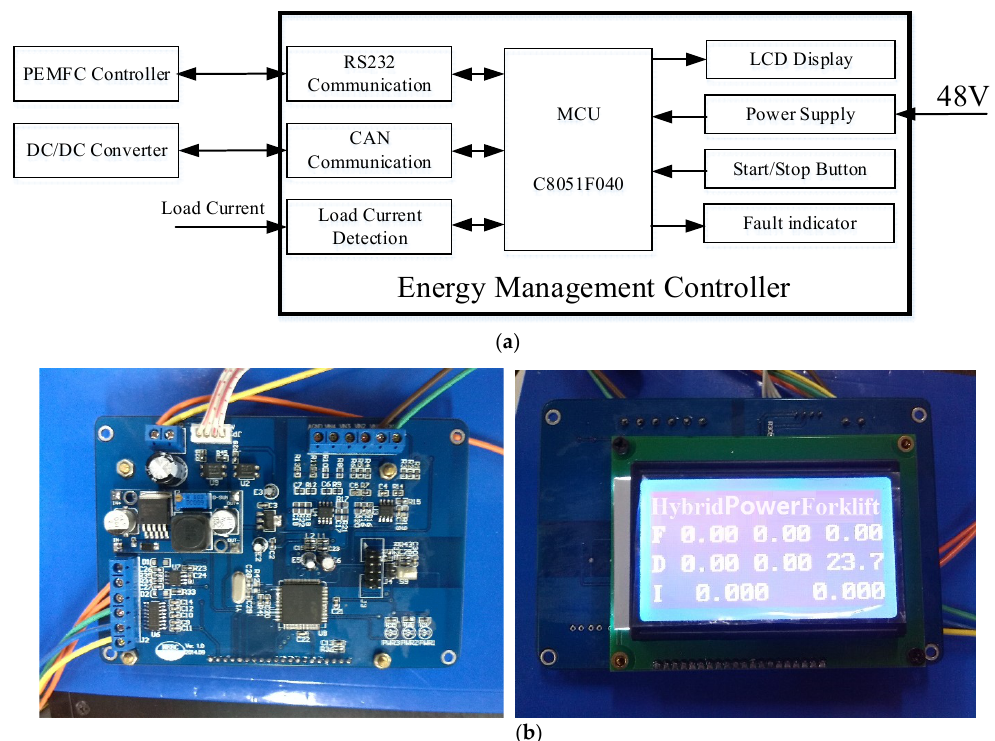
Figure 9. Energy management controller. ( a ) Functional diagram of the energy management controller; ( b ) Prototype of the energy management controller.